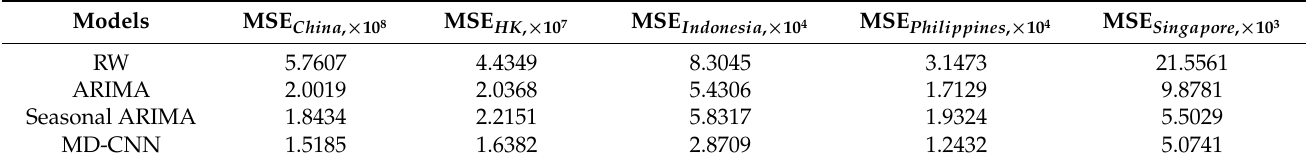
Table 3. Model performance using out-of-sample